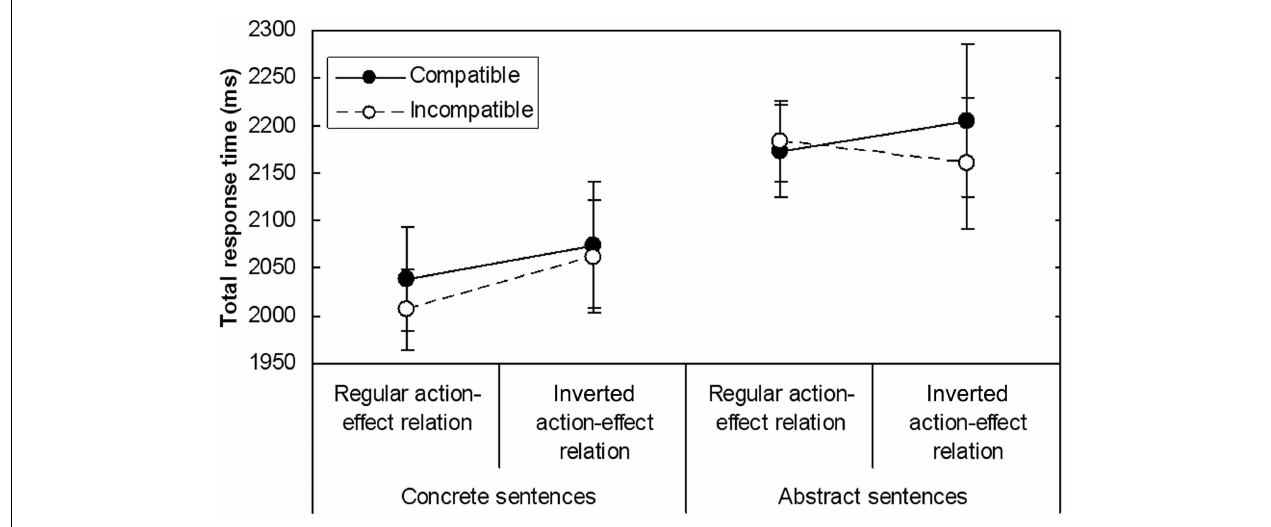
FIGURE 3 | MeanTRTs (in ms) in Experiment 1 as a function of the factors Sentence-effect compatibility,Action-effect relation, and Sentence type . Error bars indicate standard errors.